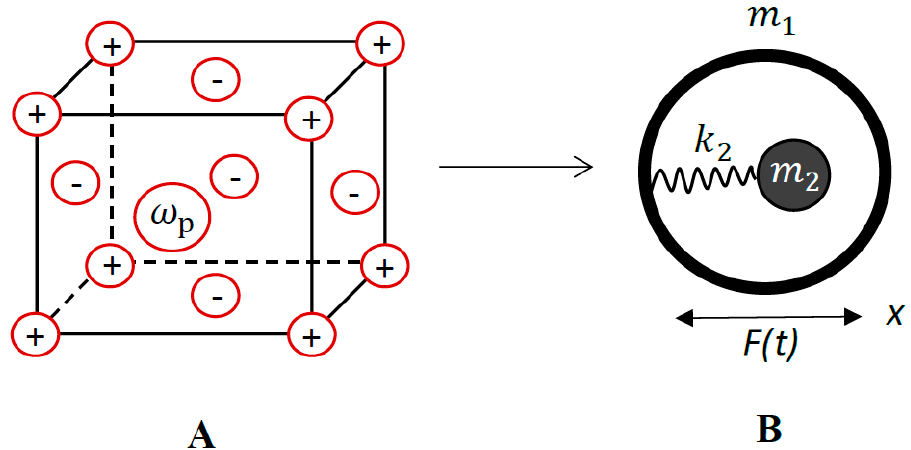
Figure 1. ( A ) Free electron gas is embedded in the ionic lattice; (cid:2033) (cid:3043) is the electron plasma frequency ( B ). The equivalent mechanical scheme of the system ( A ). Core with mass (cid:1865) (cid:2870) (free electron gas